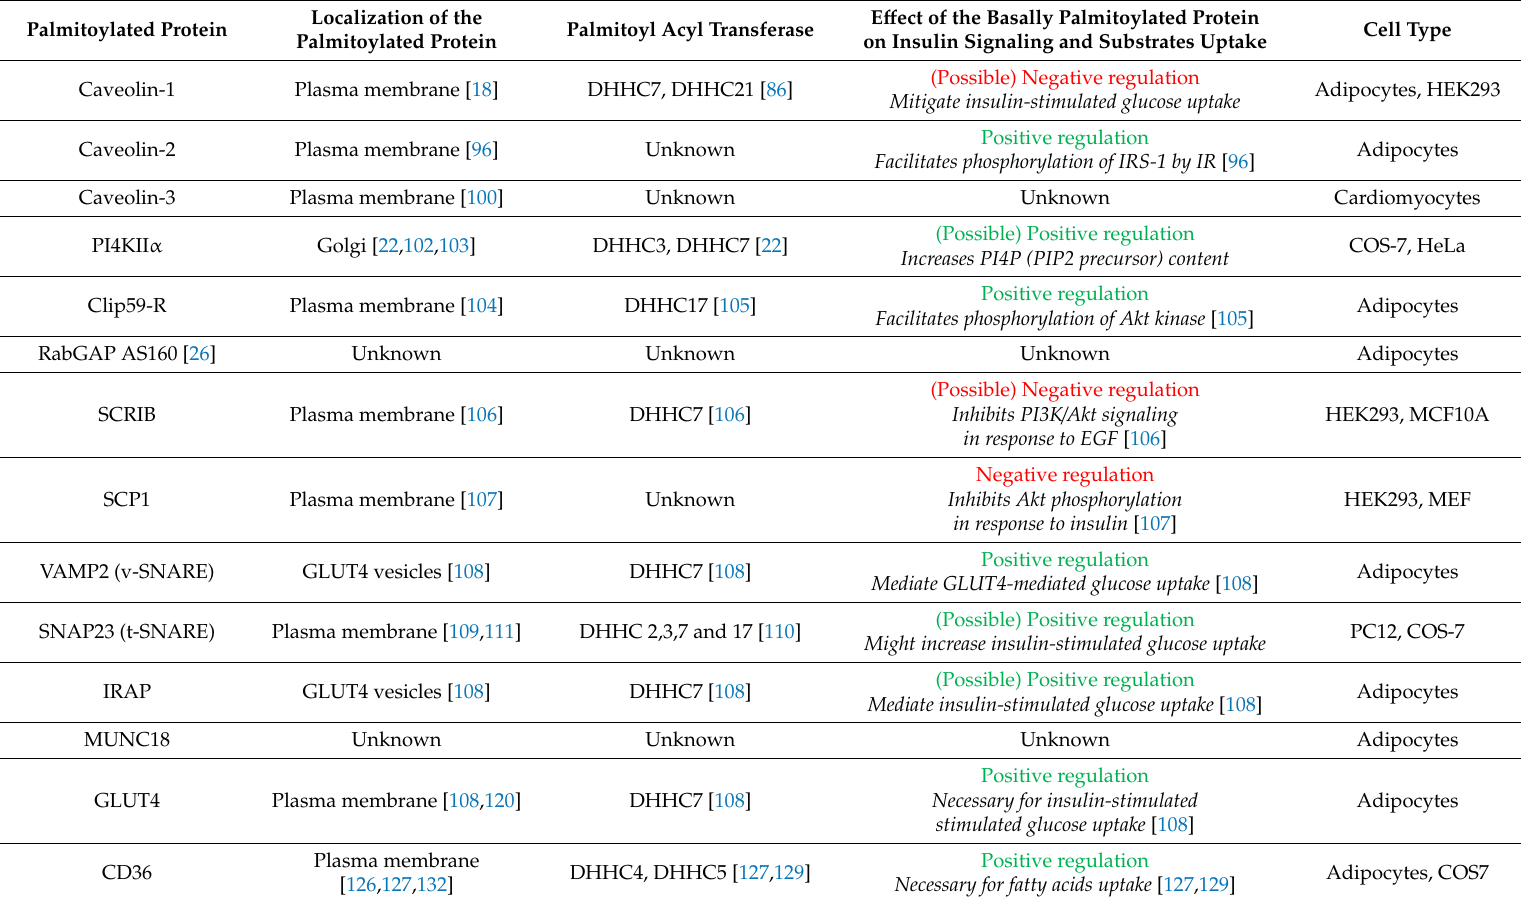
Table 1. Basal palmitoylation on insulin signaling and substrate transporters tra ffi